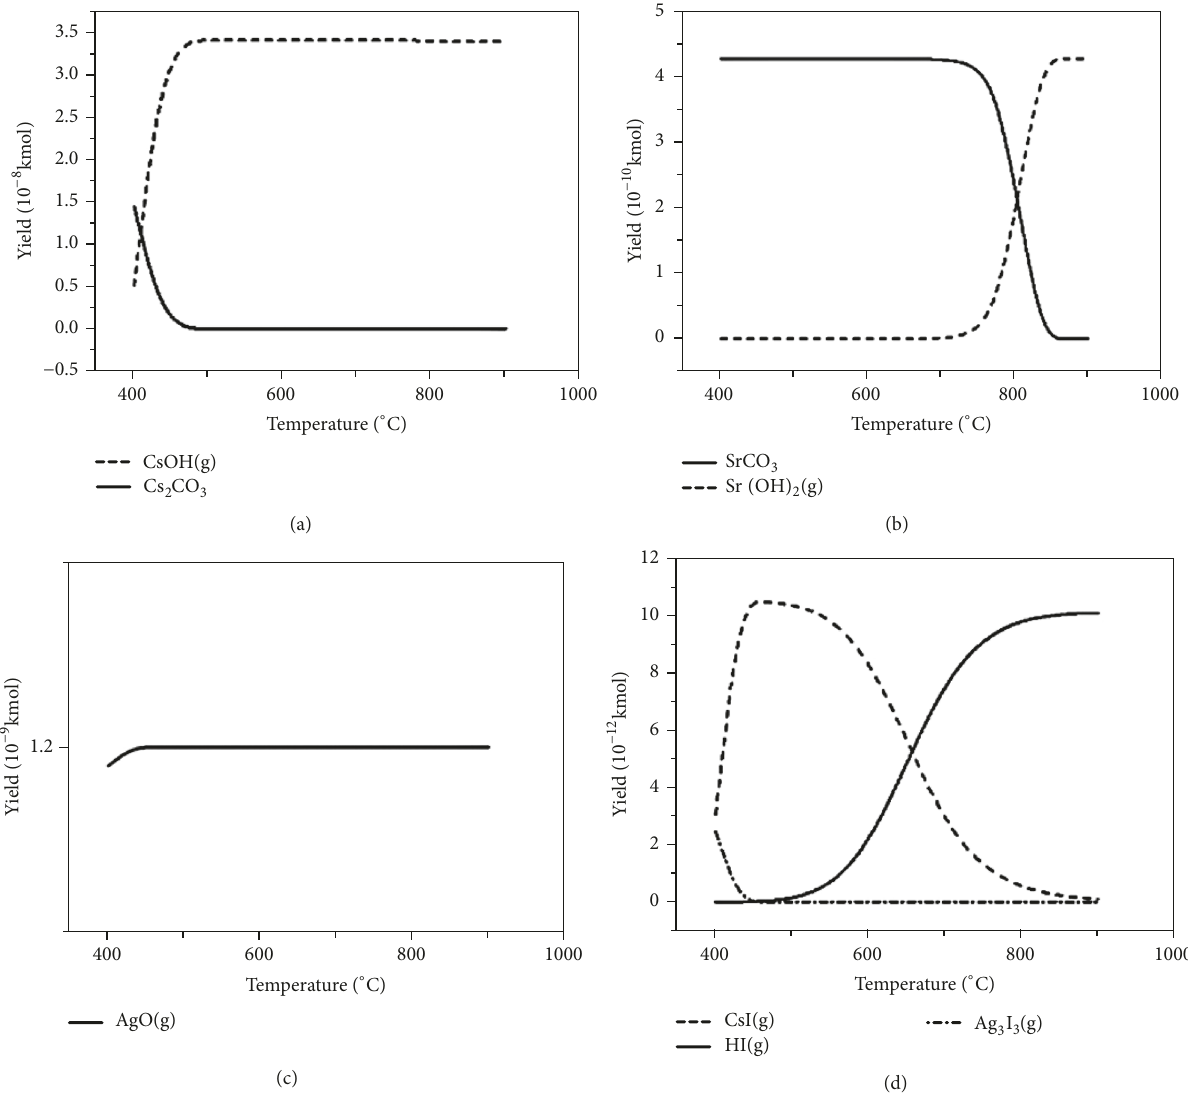
Figure 6: Variations in the chemical forms of 8h after water ingress accident: (a) Cs, (b) Sr, (c) Ag, and (d) I.